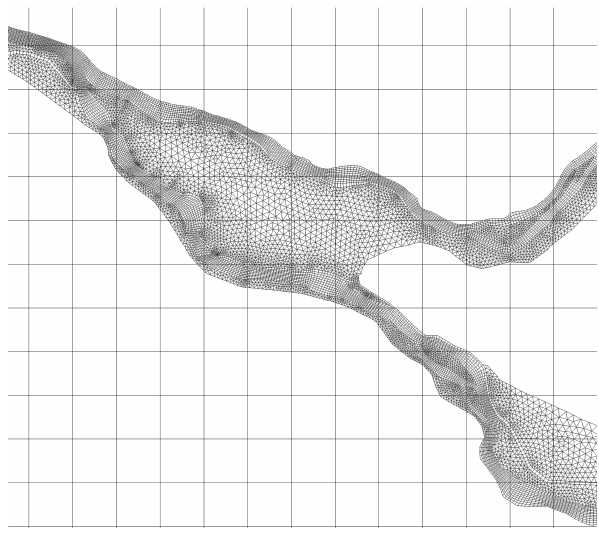
Figure 2. Modelling grid configuration for the Mezhdurechensk city